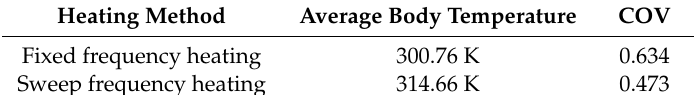
Table 4. Sweep frequency and fixed frequency heating simulation results.